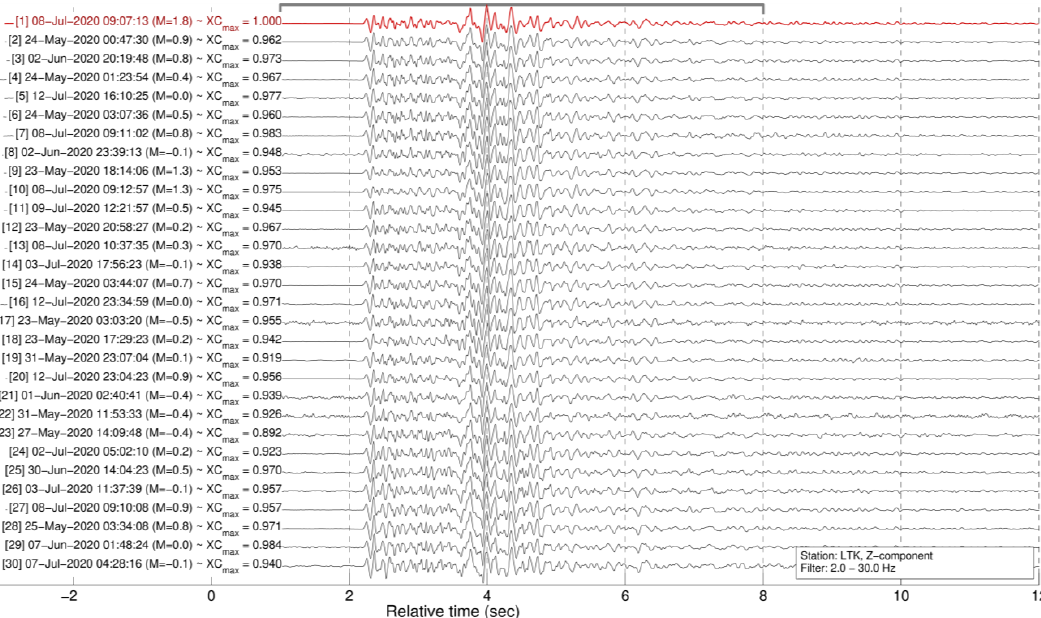
Figure A9. Waveforms of template “2020-07-08-09-07-13” (top, red) and 29 associated detections (black), belonging to multiplet #47 of CAT3 (multi-channel detections), formed with farthest-neighbor linkage at a similarity threshold of 0.50 (see also Figure 10 for the temporal distribution of this multiplet). The recordings are from the vertical component of station LTK, filtered between 2 and 30 Hz. The waveform amplitudes are normalized within the displayed window. XC max denotes the cross-correlation maximum between each waveform and the one directly above in the window marked with a gray bracket at the top. Note the high degree of similarity (XC max > 0.9) between consecutive